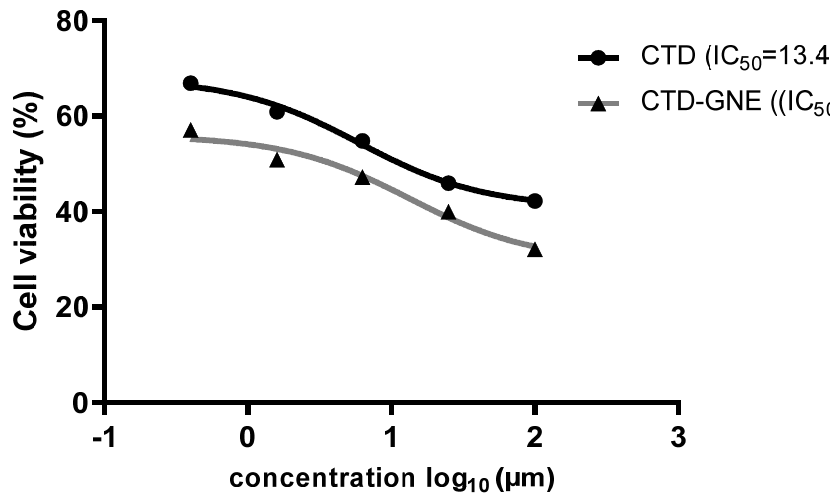
Figure 4. Viability of A549 cells using the MTT assay after 24 h of incubation with CTD or CTD-GNE